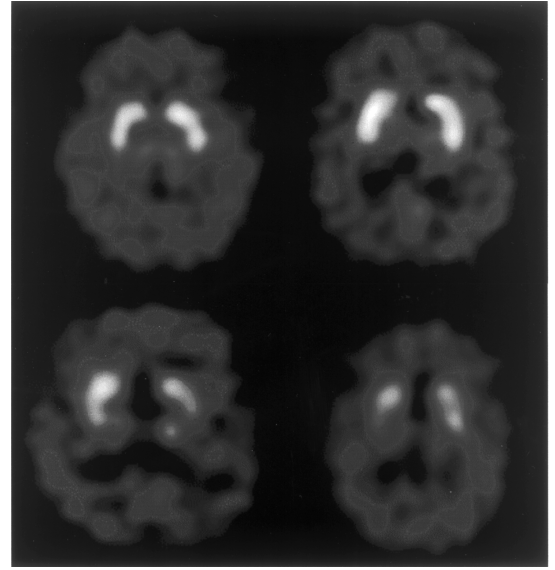
Fig. 5. SPECT images of [ 123 I]IBZM binding to postsynaptic dopamine D 2 receptors in patients with PD (top row) and MSA (bottom row). Although there is some evidence of striatal degeneration of postsynaptic receptors in MSA, a diagnosis by visual inspection alone can be difficult (image courtesy of Dr. Jim Patterson, Institute of Neurological Sciences, Glasgow). from both MRI and PET or SPECT. Regional